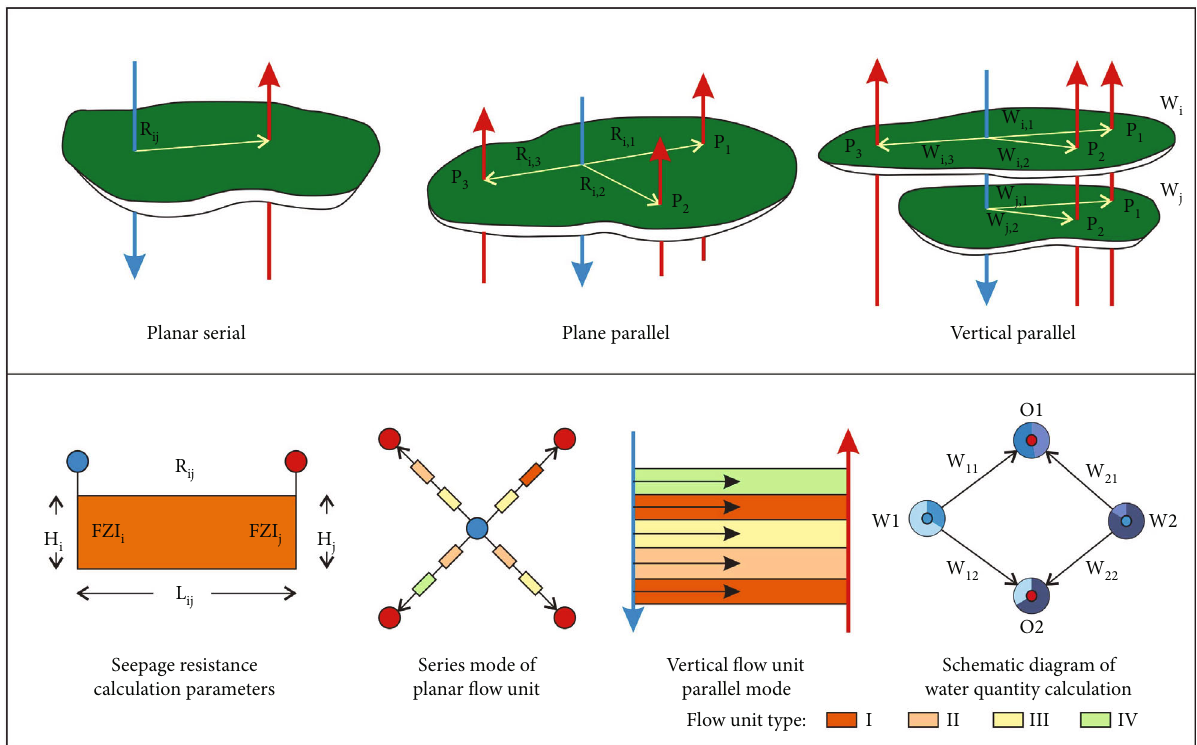
Figure 7: Discrimination mode of seepage resistance under injection production